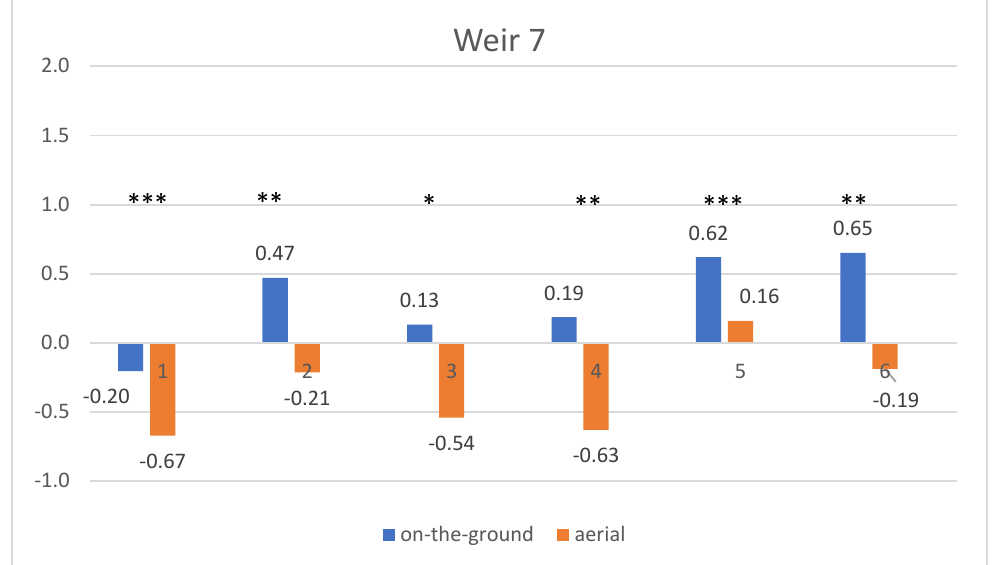
Figure 11. Mean values for preference ratings for pairs of scenarios developed from on-the-ground and aerial perspectives for weir 7 near the Hyttbakken bridge. Differences between mean values are indicated at the respective significance levels: ***, p ≤ 0.001; **, p ≤ 0.01; and *, p ≤ 0.05.